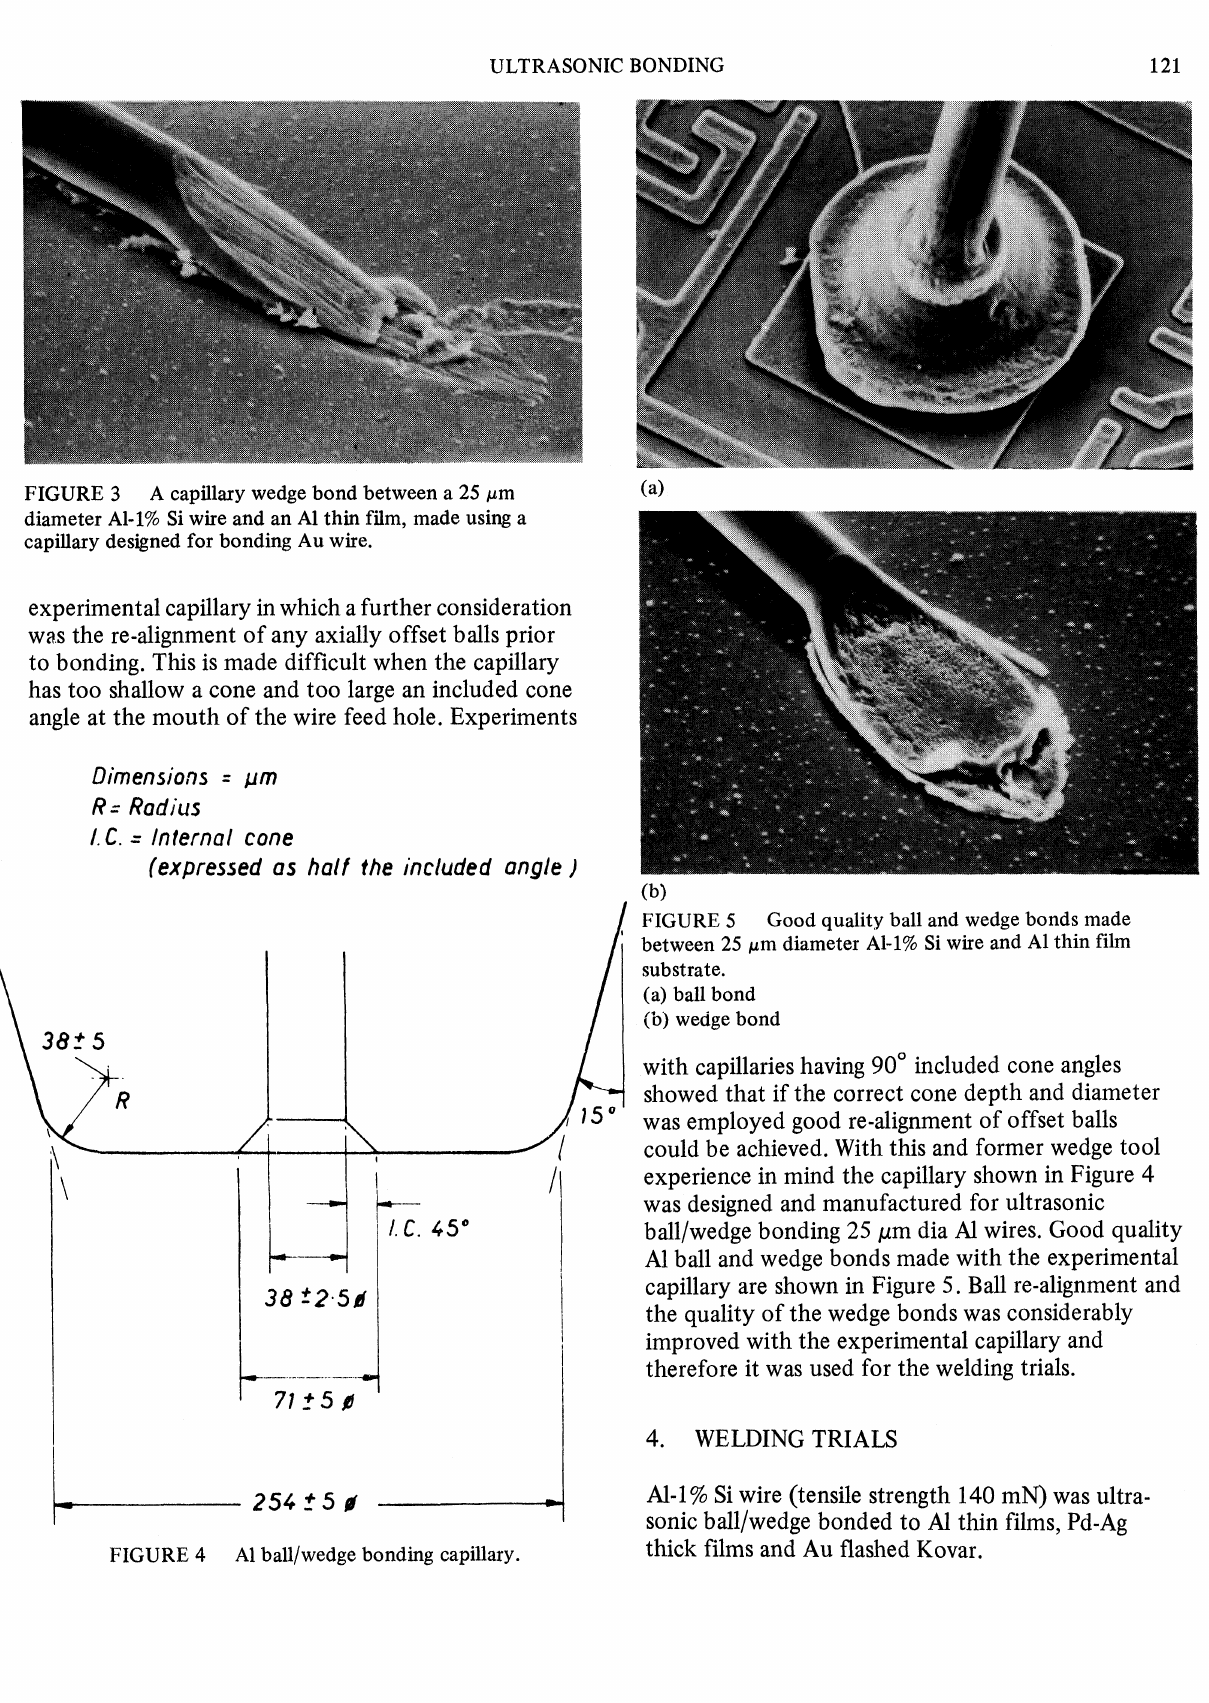
FIGURE 4 A1 ball/wedge bonding capillary.